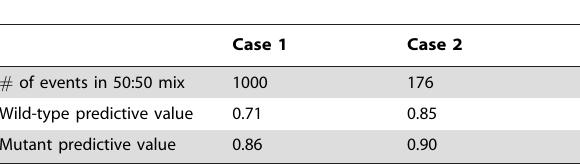
Table 1. Wild-type and mutant predictive